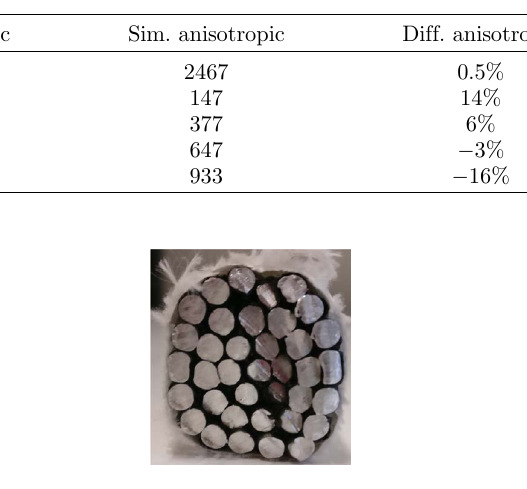
Figure 8. View of Coil55 cable section composed of 37 aluminum strands. Table 4. Magnitude of the main Lorentz force